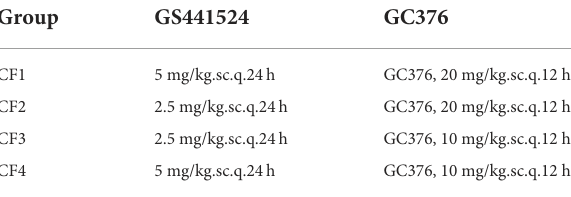
TABLE 2 The treatment